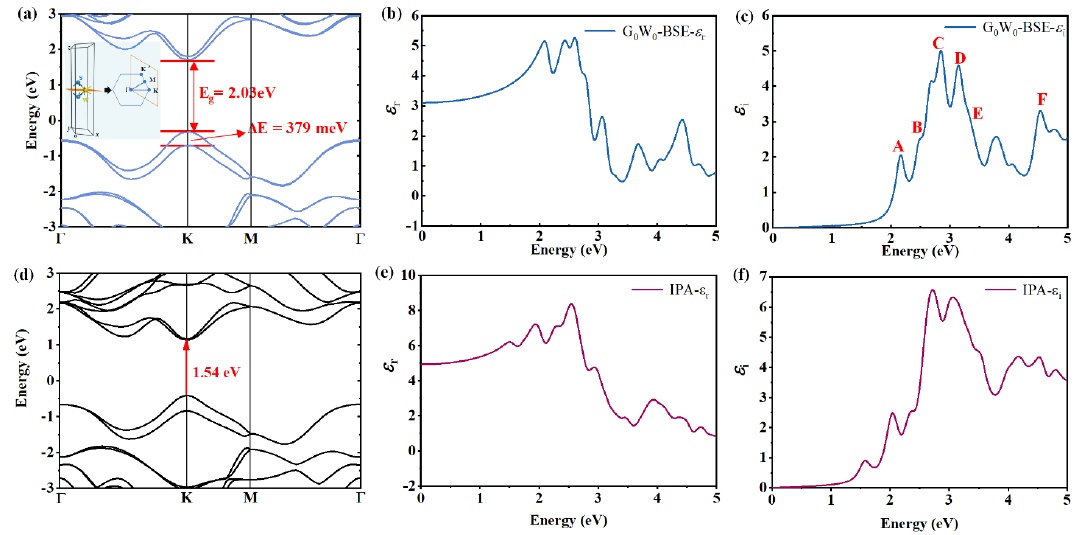
Figure 5. First-principle calculation results of the monolayer WS 2 : ( a ) the HSE06 band structure, the inset shows the Brillouin Zone; ( b , c ) real part and imaginary part of the G 0 W 0 + BSE calculated dielectric function spectra; ( d ) the PBE band structure; ( e , f ) real part and imaginary part of the IPA dielectric spectra. Uppercase letters A–F represent the CPs. Figure 5b,c and Figure 5e,f display the dielectric function spectra of the monolayer WS 2 calculated under G 0 W 0 -BSE and IPA approximations, respectively. The excitonic ef- fects have been taken into consideration in the G 0 W 0 -BSE calculations, while the IPA does not involve the excitonic effects, and that is why peaks A and B in Figure 5e,f are weaker than the G 0 W 0 -BSE results in Figure 5b,c. In addition, the IPA results are based on the PBE functional, so the energy positions of A and B are smaller than the results of G 0 W 0 -BSE. It can be seen that the shapes of the theoretically calculated dielectric function spectra are similar to the experimentally determined dielectric function spectra as provided in Figure 4. Additionally, around the center energies of the experimentally determined CPs as sum- marized in Table 1, the G 0 W 0 -BSE theoretically calculated dielectric function spectra also exhibit six corresponding feature peaks (A–F) as presented in Figure 5c. For example, the center energies of peak A and B in Figure 5c are approximately 2.16 eV and 2.50 eV, which are close to the energy positions of CP A and B (2.02 eV and 2.41 eV) in Figure 4d. As a consequence, the agreement between the experimental and theoretical results demon- strates the reliability of the SE results. However, it should be mentioned that the theoreti- cal dielectric function spectra contain more detailed peaks, which are difficult to be dis- tinguished in the experimental dielectric function spectra. This difference can be ex- plained by the fact that in the experimental spectra, some adjacent detailed optical transi- tions may be combined into one wide-band complex optical transition especially in the high-energy regions. Another reason is that the theoretical calculations depend on the specifically adopted first-principle tools to a certain extent, and different tools are based on different theoretical approximations and consequently produce different details in the calculated results. Finally, based on the CP analysis on the SE-determined optical functions and first- principle calculated results, we can systematically identify detailed information of the CP optical transitions in the monolayer WS 2 by using the proposed method. Figures 6a and 6b, respectively, show the band structure and PDOS of the monolayer WS 2 , where V i and C i refer to the i -th highest VB and the i -th lowest CB, respectively. Figure 6c illustrates the differential band structure E C−V ( K ), namely the energy difference curves between the three lowest CBs and the three highest VBs, which may be involved in the optical transitions